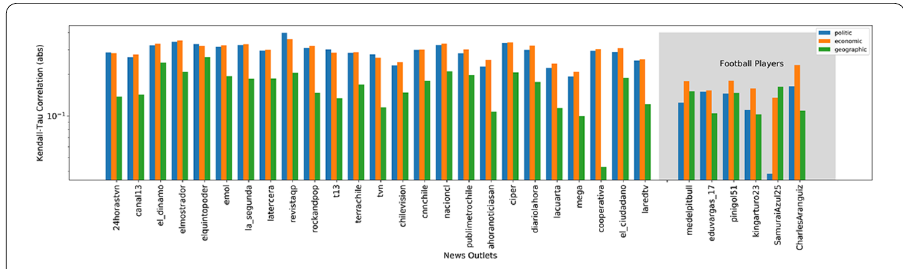
Figure 6 KT correlation for communes in the Metropolitan Region for the top 25 news outlets. Each feature is correlated with the number of followers’ ranking